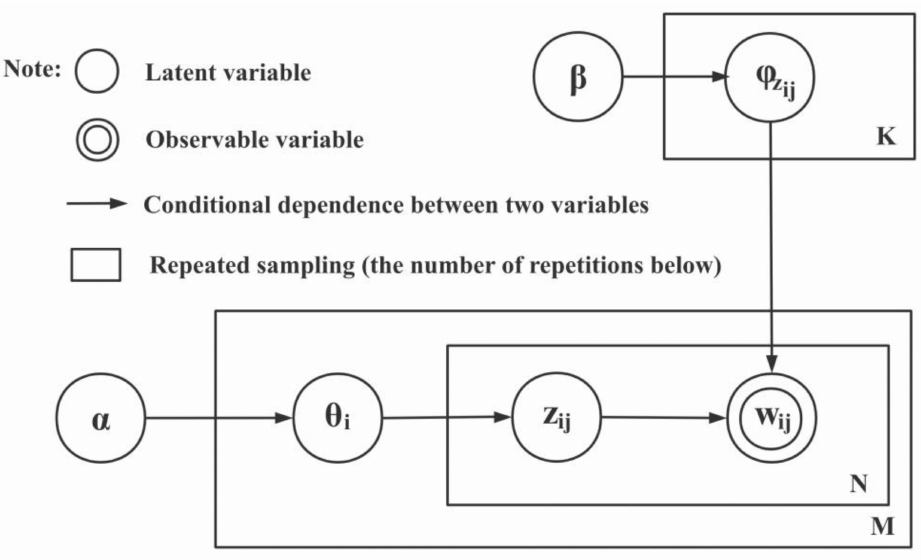
Figure 1. LDA topic analysis